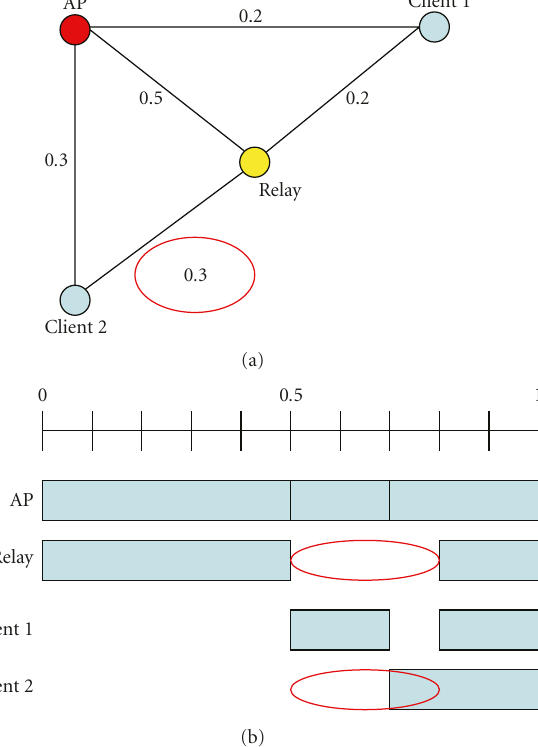
Figure 7: Illustration of triangle